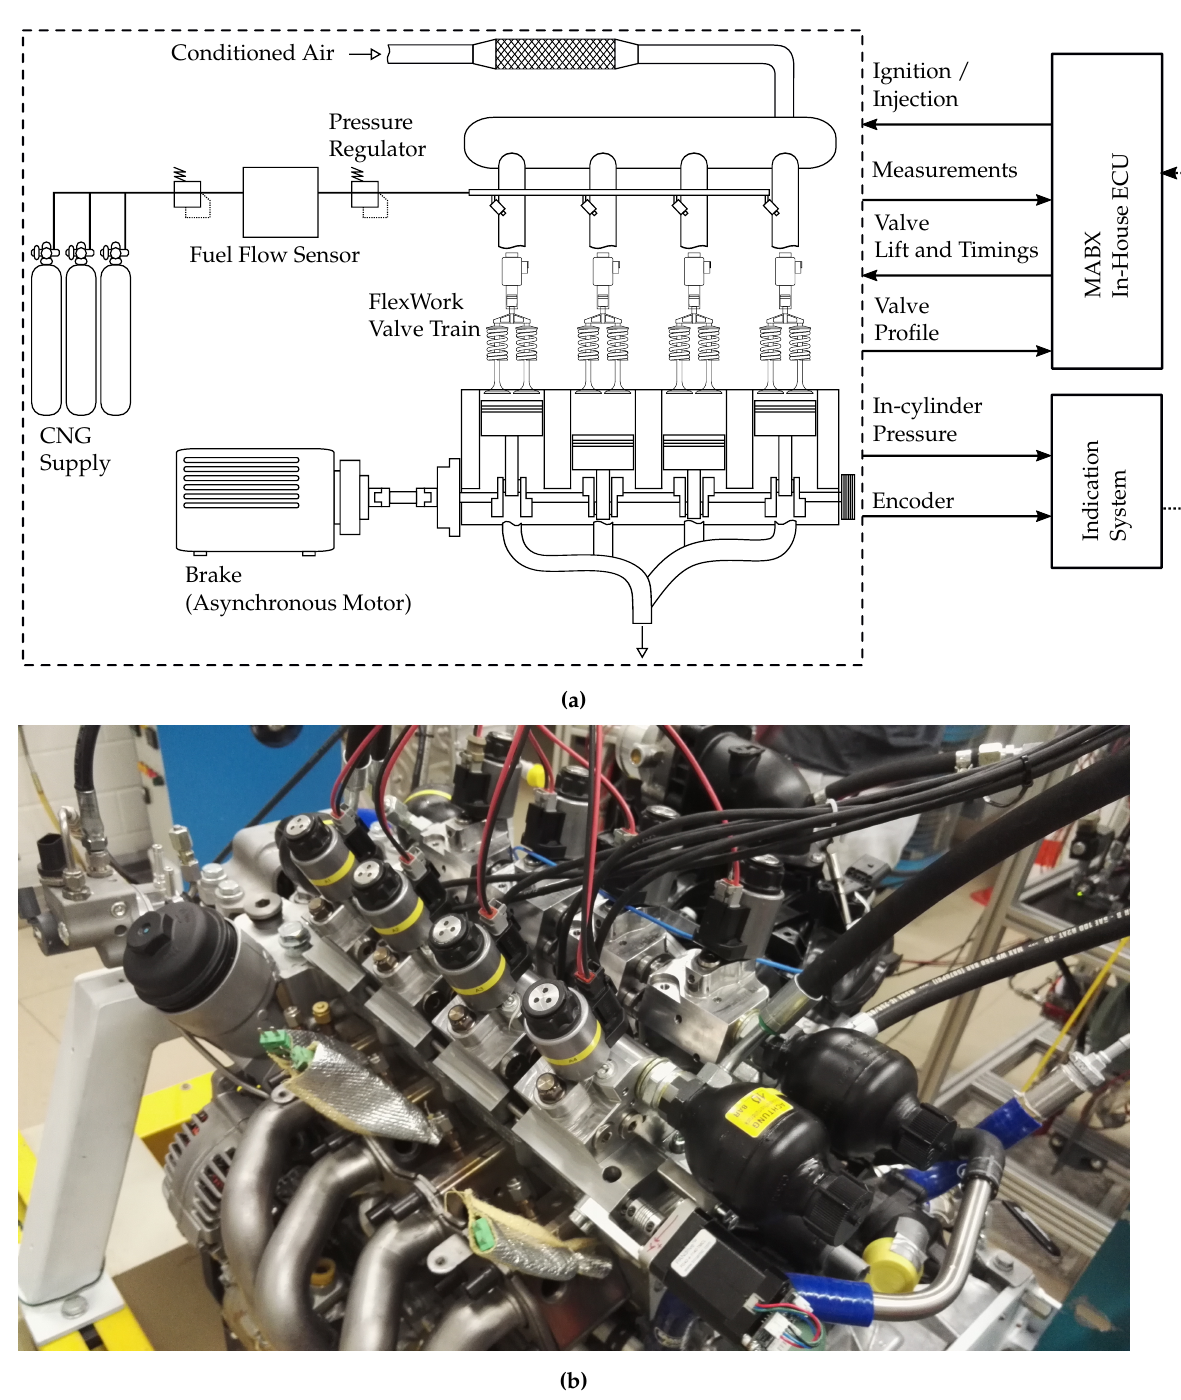
Figure 1. Schematic representation ( a ) and photograph ( b ) of the test bench with the fully variable valve train FlexWork mounted on the EA111 engine.